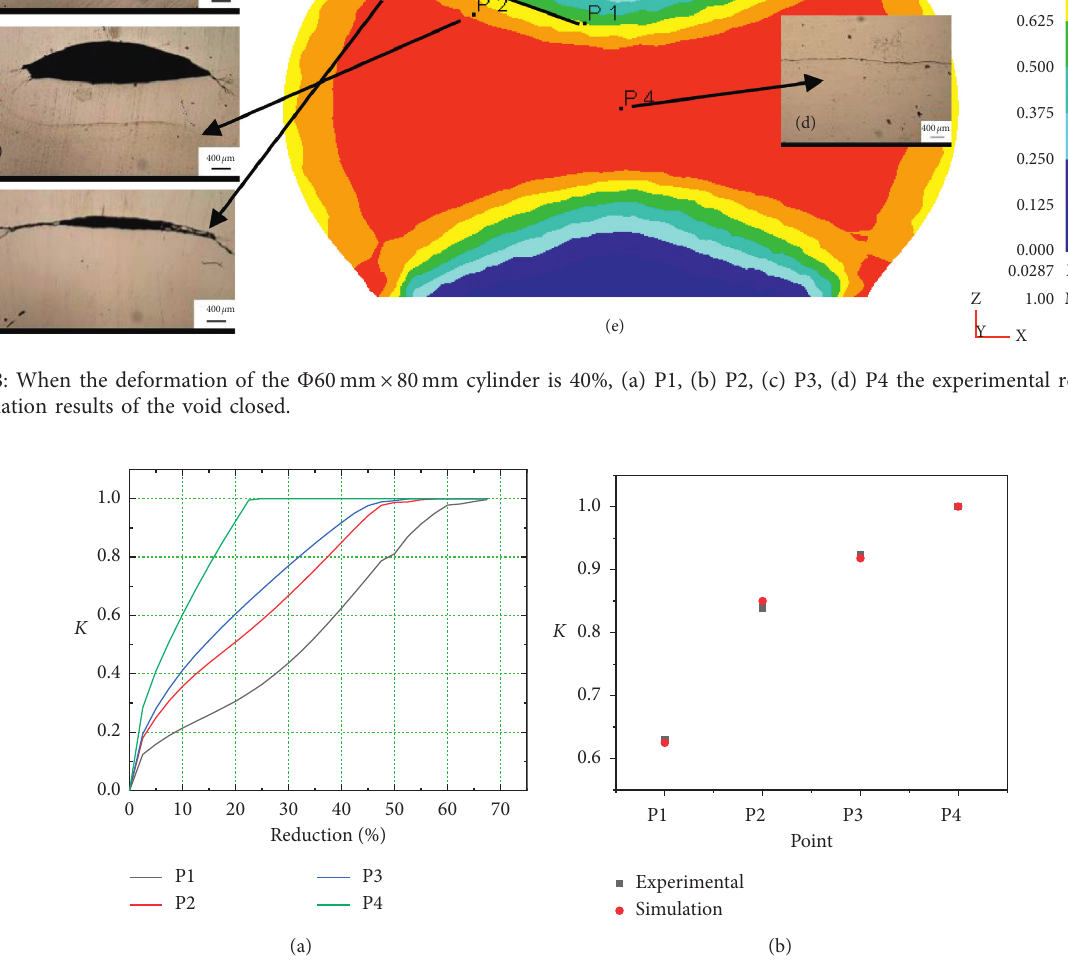
Figure 9: Φ 200 mm × 2600mm cylinder. (a) FEM simulation of void closure ratio K at P1, P2, P3, and P4 positions. (b) Experimental and simulation results of void closure ratio K at P1, P2, P3, and P4 positions when the deformation is